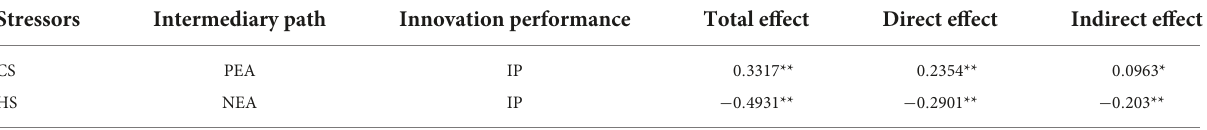
TABLE 5 Tests on the mediation effect of positive and negative emotional atmosphere.